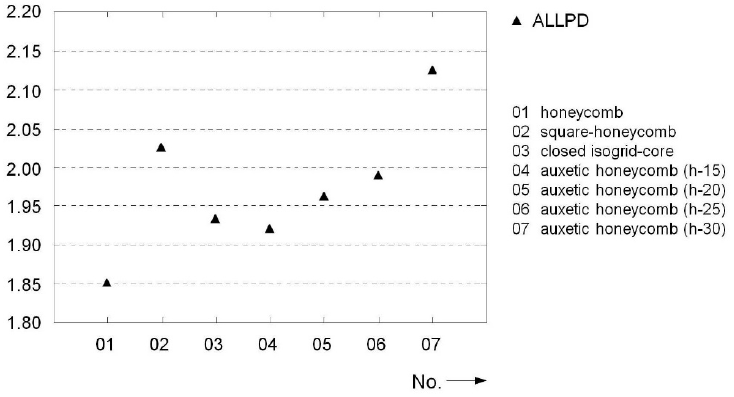
Figure 21. Honeycomb cores: normalized maximum values for plastic dissipation energy.